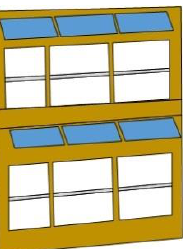
Figure 1. Overhang photovoltaic (PV) collector (blue) on building façade.